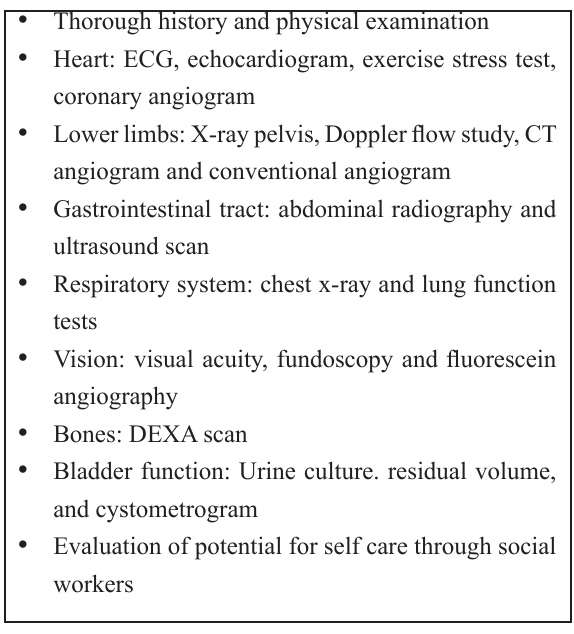
Table II : Assessment for